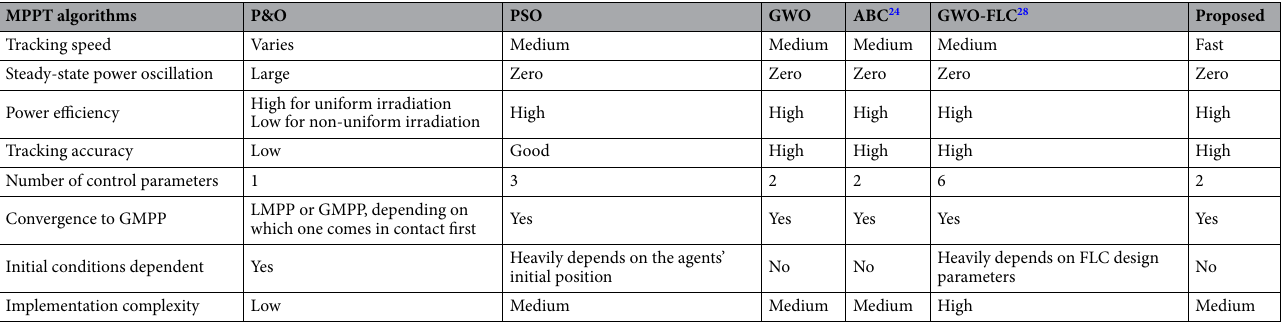
Table 5. Comparison of the GWO–PSO-based mppt with other mppt techniques on a qualitative